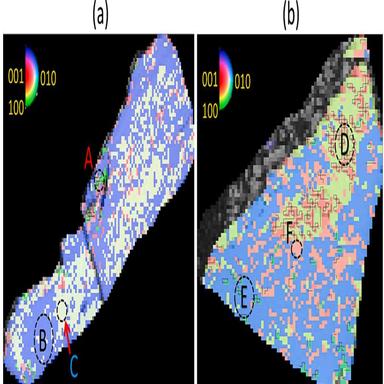
The EBSD orientation mapping of the concentrate sample for two different grains (a) and (b). The indicated sites (A) to (F) correspond to the same locations shown in Fig. 6.